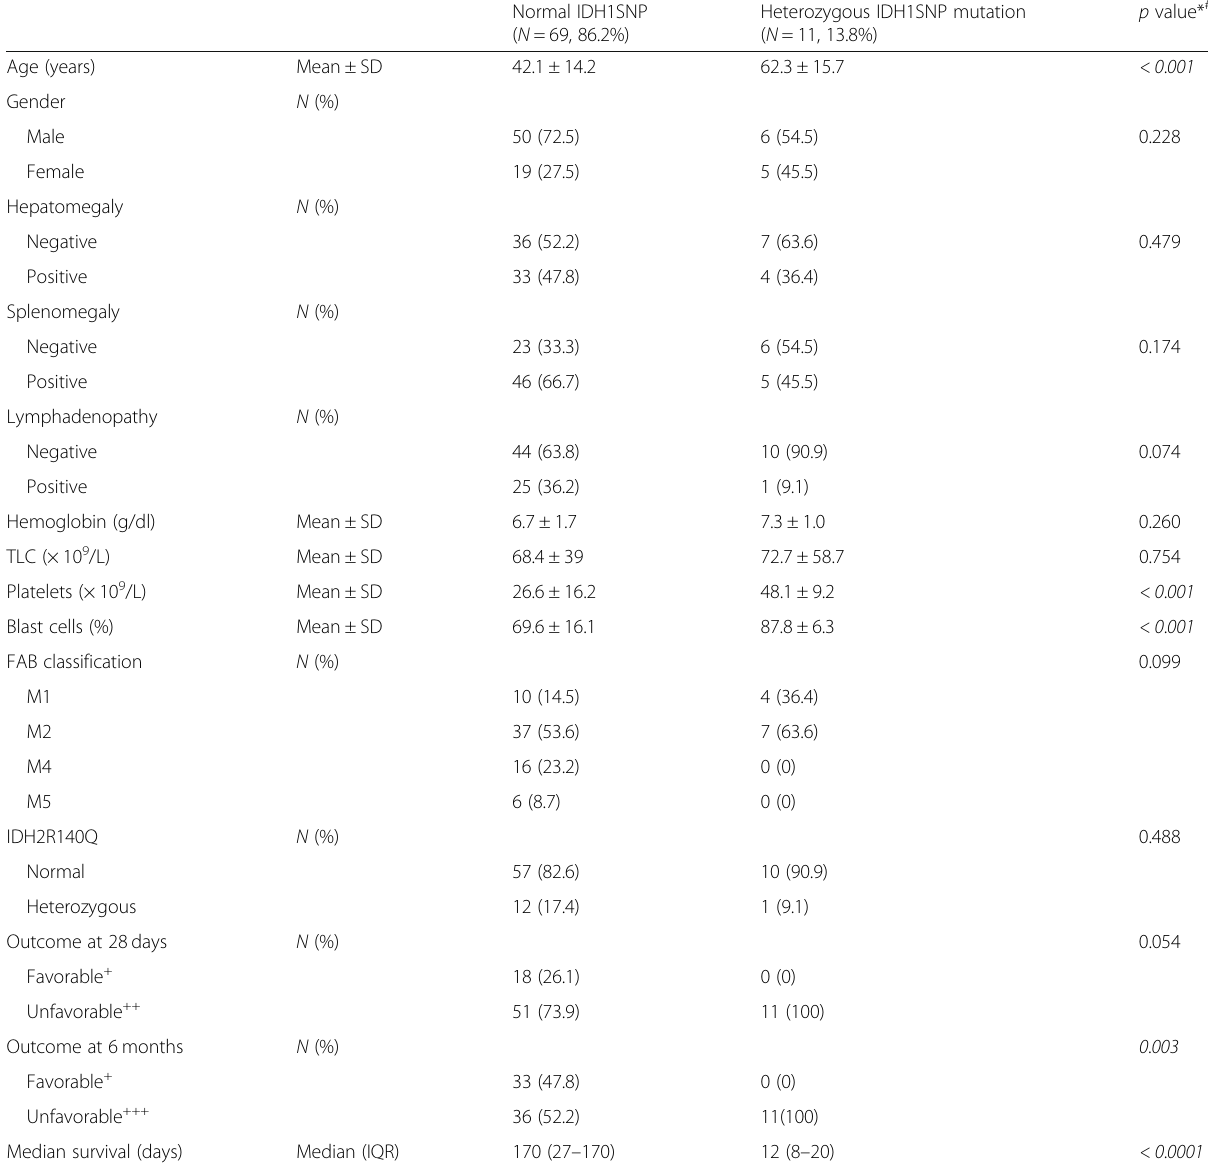
Table 3 Comparison between normal and mutant IDH1 SNP rs11554137 patients